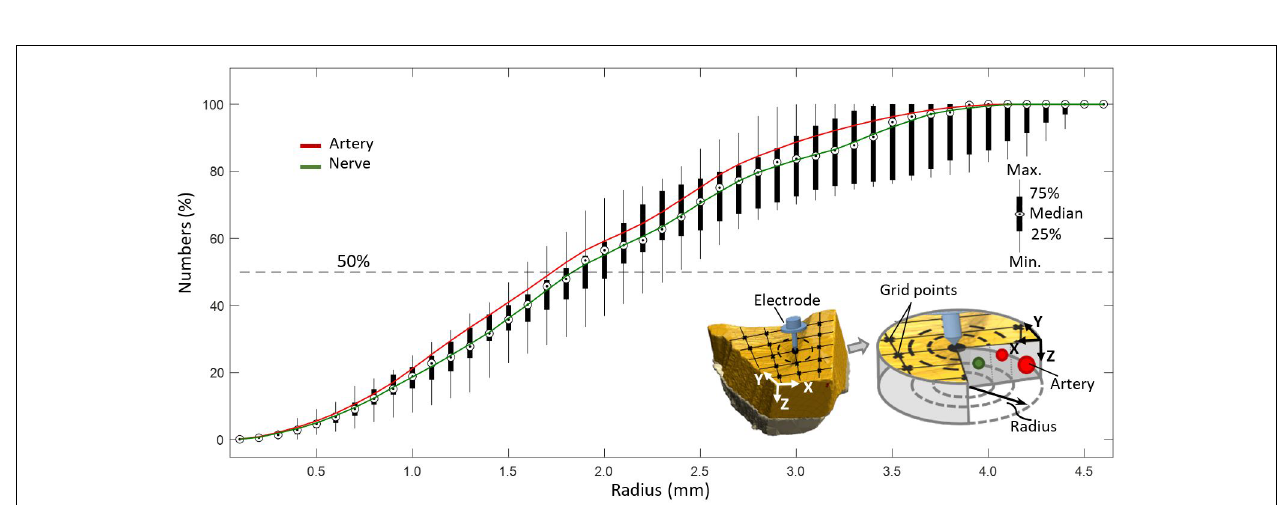
FIGURE 7 | Coverage of arteries and nerves with increasing radius from a point on a predefined grid with resolution of 0.1 mm.